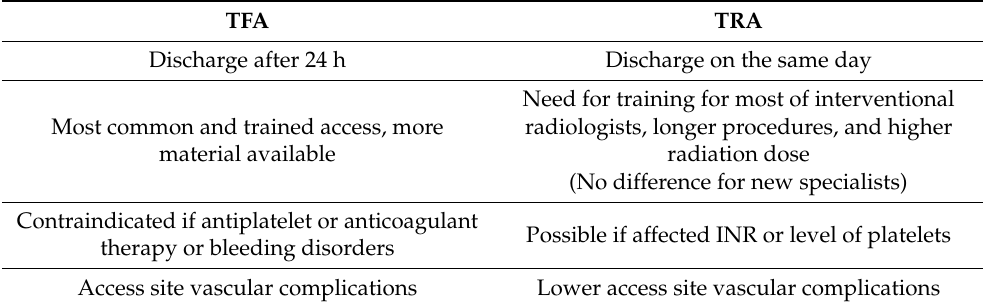
Table 5. Comparison between femoral and radial access. TFA TRA Discharge after 24 h Discharge on the same day